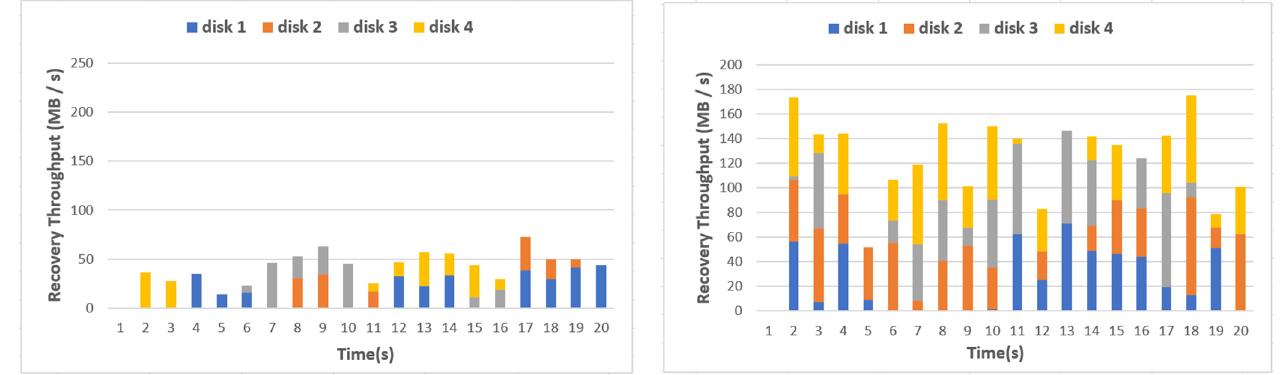
Figure 22. Comparison of recovery performance according to the number of recovery threads.